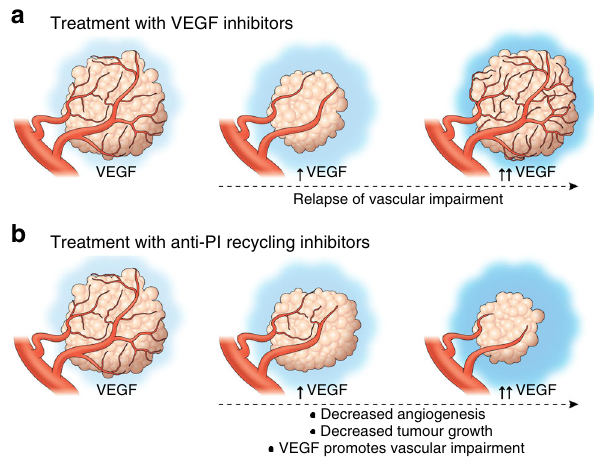
Fig. 6 Proposed model for inhibition of tumor growth with anti-VEGF versus anti-PI recycling therapies. a Currently available anti-angiogenic therapies targeting VEGF lead to an initial decrease in tumor growth and angiogenesis. However, production of high levels of pro-angiogenic ligands by tumors results in a relapse in vascular impairment and return of tumor growth. b Our results indicate that targeting PI recycling leads to reduced tumor vasculature and tumor growth, and further suggest that the effects on tumor angiogenesis and tumor growth may be strengthened, not overcome, as tumor production of VEGFA and/or other cytokines